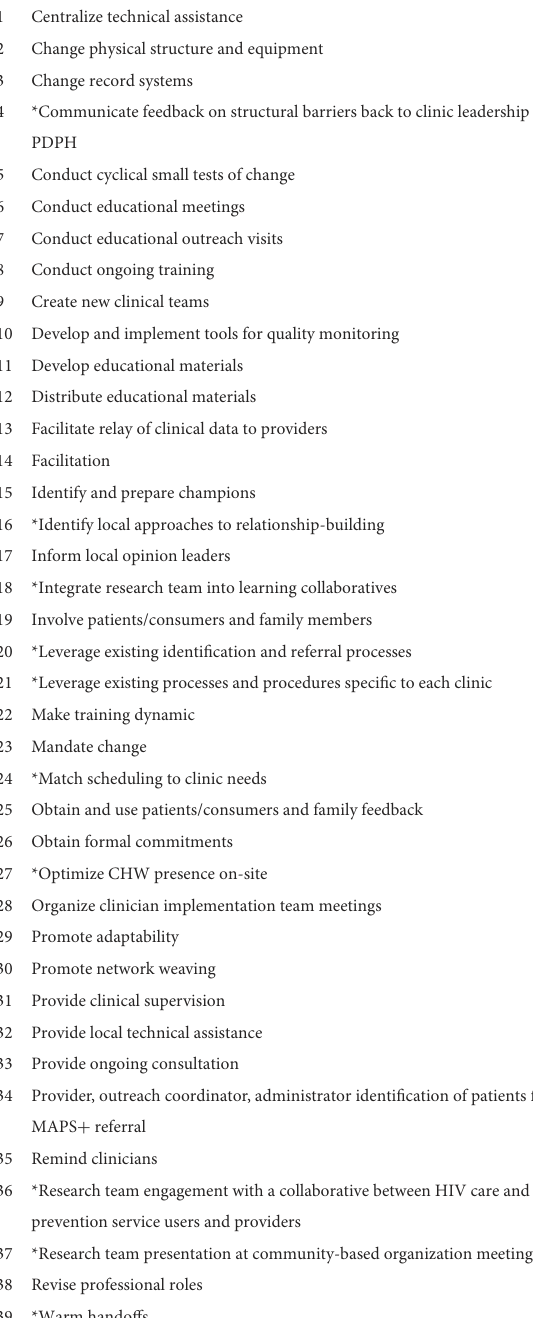
TABLE 3 Final list of implementation strategies ( N =